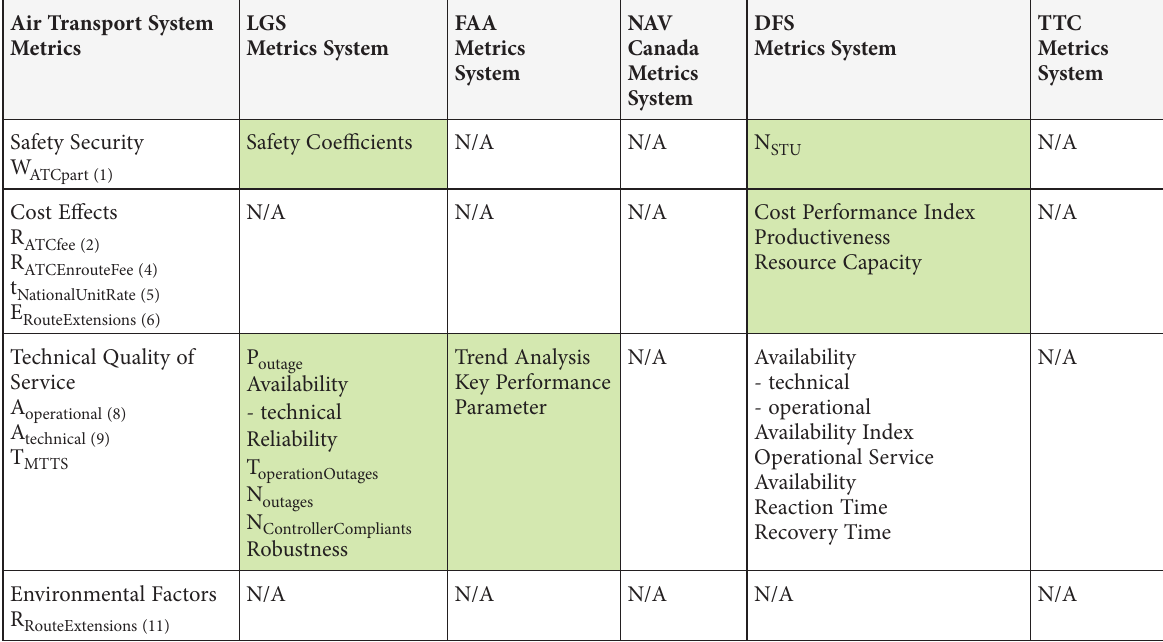
Table 3. Comparison of metrics used by ATC